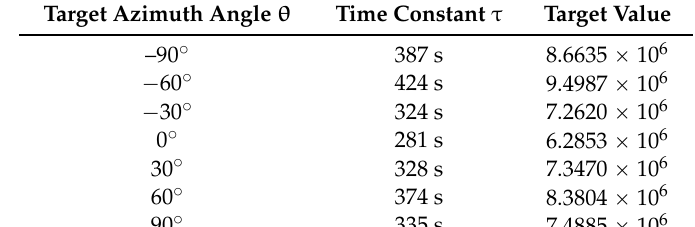
Table 10. The measures of time constant and quality factor in according to target angle.